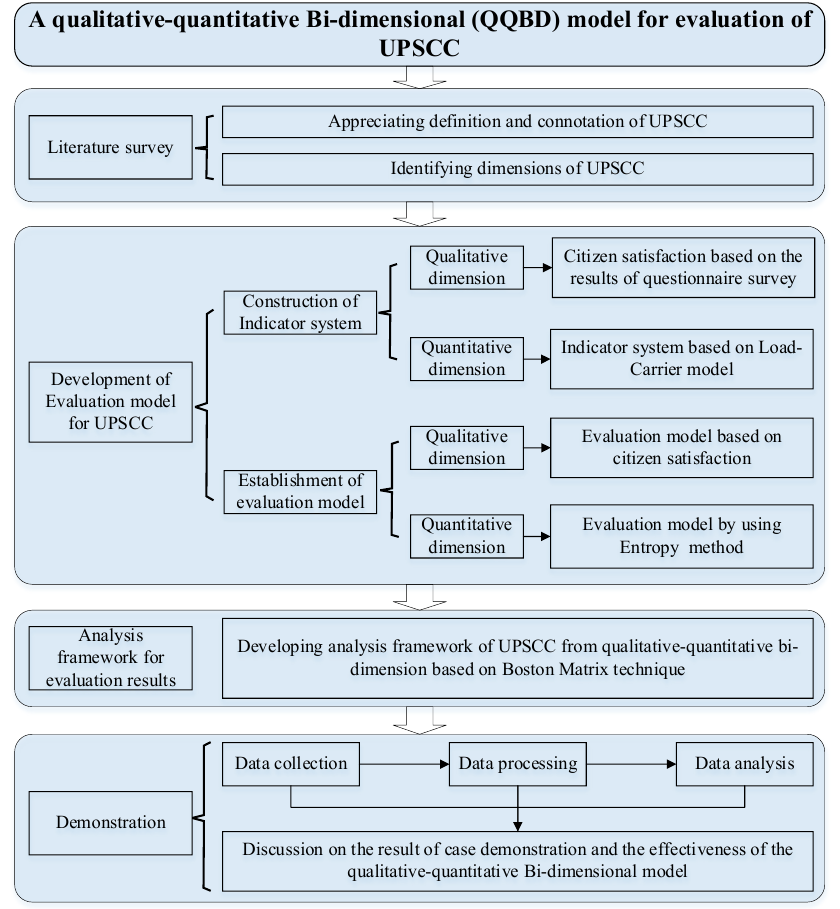
Figure 1. Research